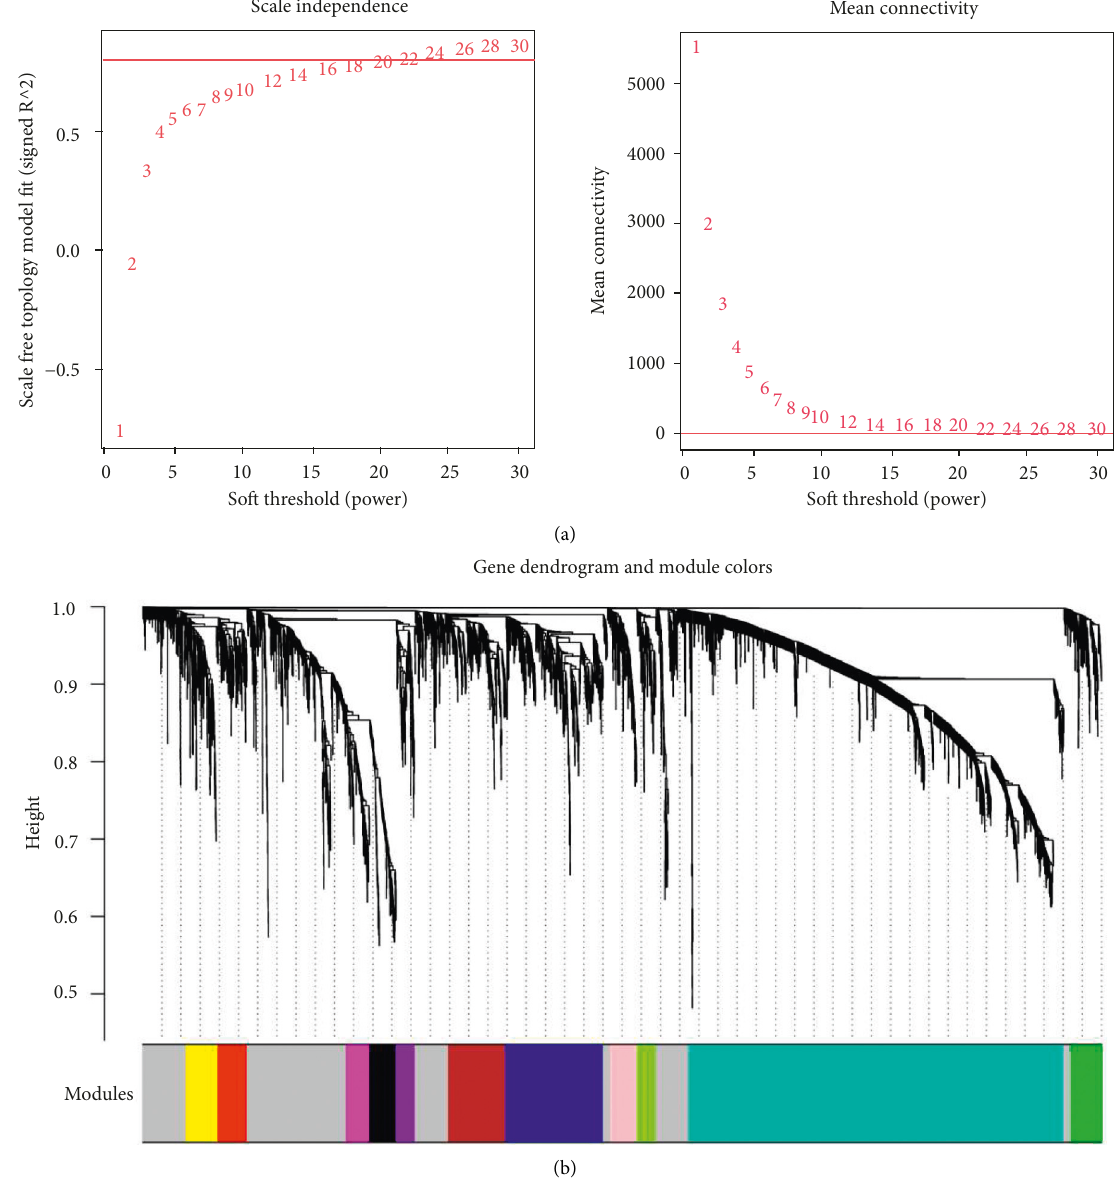
Figure 4: As shown in Figure 4(a), we select the value of power when the square value of correlation coefficient reaches 0.9 for the first time, that is, power = 22. As shown in Figure 4(b), a total of 12 modules are